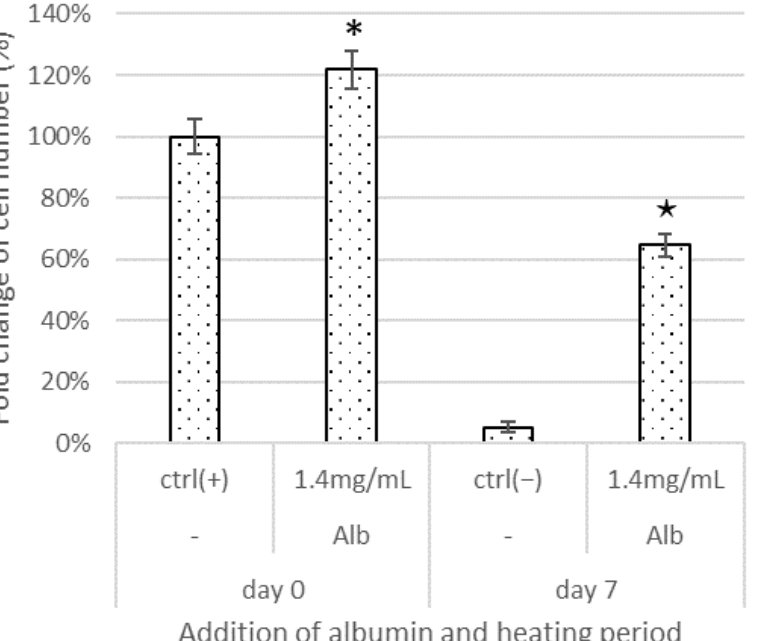
Figure 5. Effects of albumin and thermal treatment on iPSC proliferation. The fold-changes of cell numbers are shown. Differences between the cell numbers of test culture and positive control and negative control were considered significant at *, ★ p < 0.05, respectively. Alb: albumin. Microsoft Excel for Microsoft Apps for Enterprise was used for preparation of the figure.